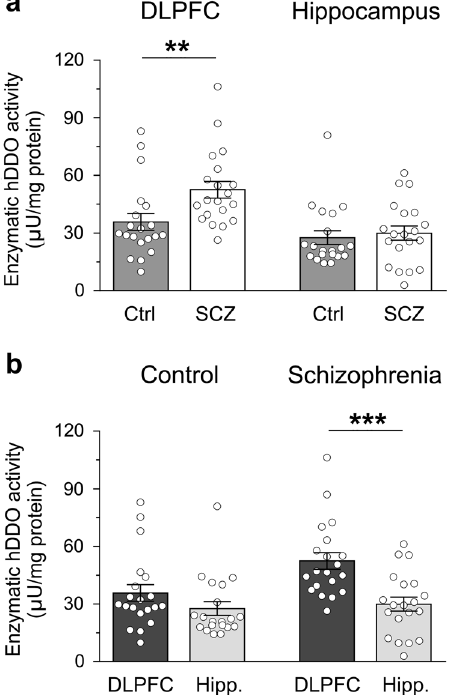
Fig. 4 Enzymatic activity of human D -aspartate oxidase ( hDDO ) in the dorsolateral prefrontal cortex ( DLPFC ) and hippocampus ( Hipp .) of patients with schizophrenia ( SCZ ) and control (Ctrl) subjects. DDO enzymatic activity is analyzed a between the two diagnosis groups (DLPFC: Ctrl, n = 20; SCZ, n = 20 − hippocampus: Ctrl, n = 20; SCZ, n = 19), and b between the two brain regions (Ctrl: DLPFC, n = 20; hippocampus, n = 20 − SCZ: DLPFC, n = 20; hippocampus, n = 20). The enzymatic activity of DDO is expressed as μ U/mg of total